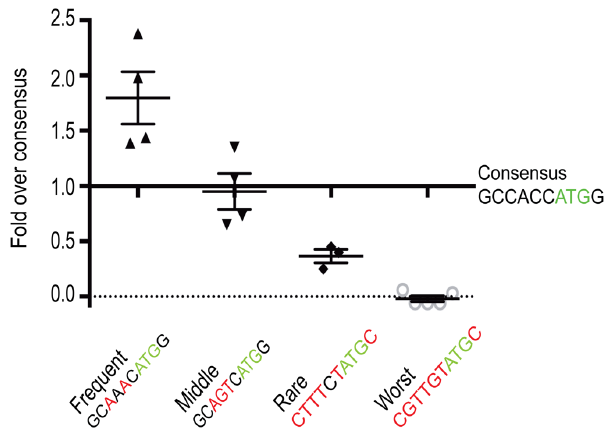
Figure 4. Nucleotide sequence surrounding translational start sites modifies expression levels. Translational efficiency is mea- sured by fluorescent expression relative to the canonical/consensus Kozak sequence. All samples are statistically different from each other (p , 0.04) except for Kozak vs. Middle. Each condition represents 4 replicates of 25 embryos each. One replicate from each condition was performed at the same time (i.e. one set) in order to achieve maximal consistency, and the replicate for the consensus Kozak sequence from that set was used to normalize the other conditions. Therefore, the consensus Kozak relative expression level is defined as 1 for each set of replicates, and that number lacks error bars. The fold over/under consensus has an order of magnitude range, providing no sign of assay saturation. most frequent translational start site in zebrafish (108/12926) (see List S1).